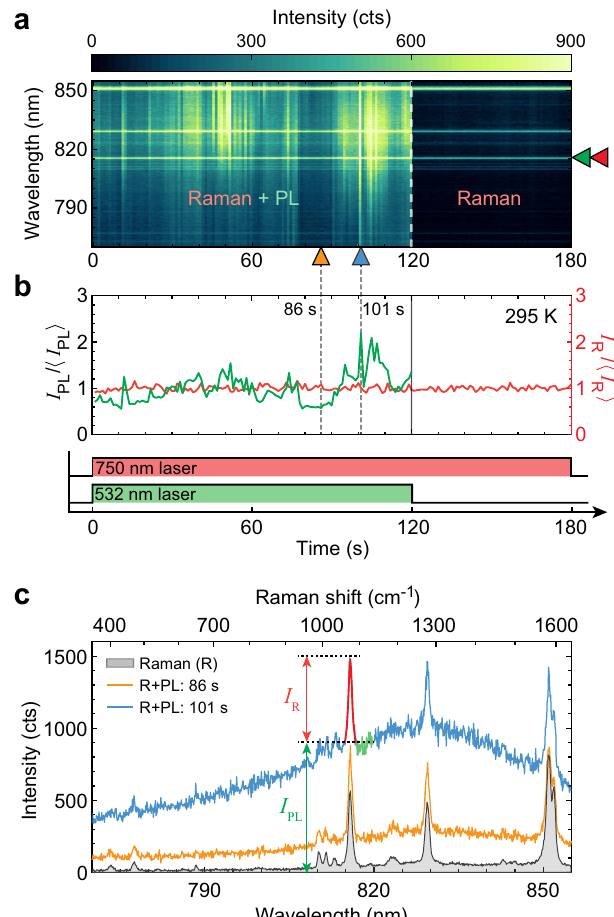
Fig. 3 Blinking PL with stable plasmon-enhanced Raman spectra. a Time series of emission spectra acquired under dual excitation with 532 and 750 nm laser beams ( fi rst 120 s) with respective power densities ~200 and ~10 μ W μ m − 2 , and then with 750nm excitation alone (after 120 s). Camera exposure time = 1 s; numerical aperture: 0.95; room temperature. The color scale is saturated for better visibility of the fl uctuations. b Time series of the PL intensity (cf. I PL in c ) and PL-subtracted Raman intensity (cf. I R in c ), normalized by their respective time-averages ( 〈 I PL 〉 and 〈 I R 〉 ). c Example of individual Raman + PL spectra (blue and orange curves) and time-averaged Raman spectrum under 750 nm excitation alone (120 – 180 s, gray area). The green and red-substituted points on the blue curve highlight how I PL and I R are de fi